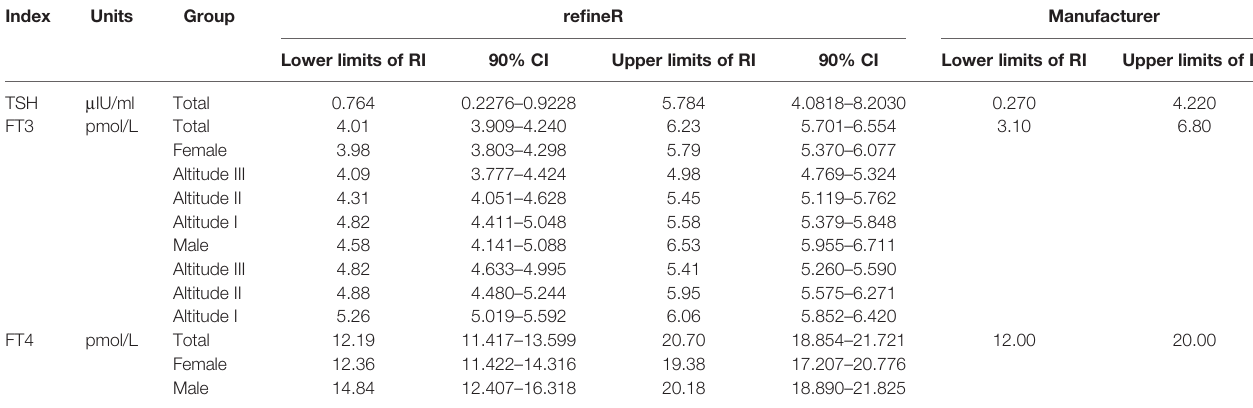
TABLE 4 | Reference interval of thyroid-associated